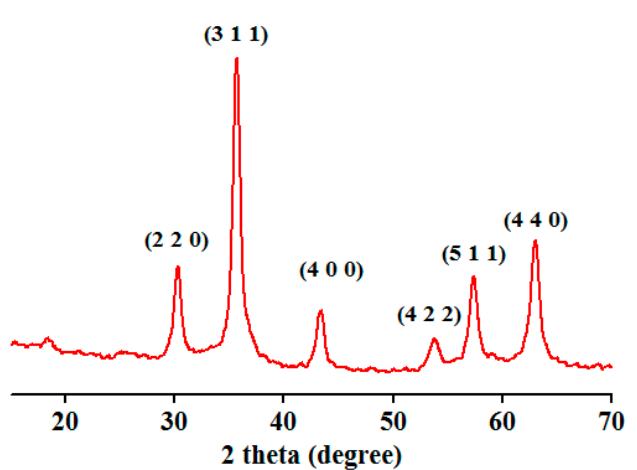
Figure 2. XRD pattern of